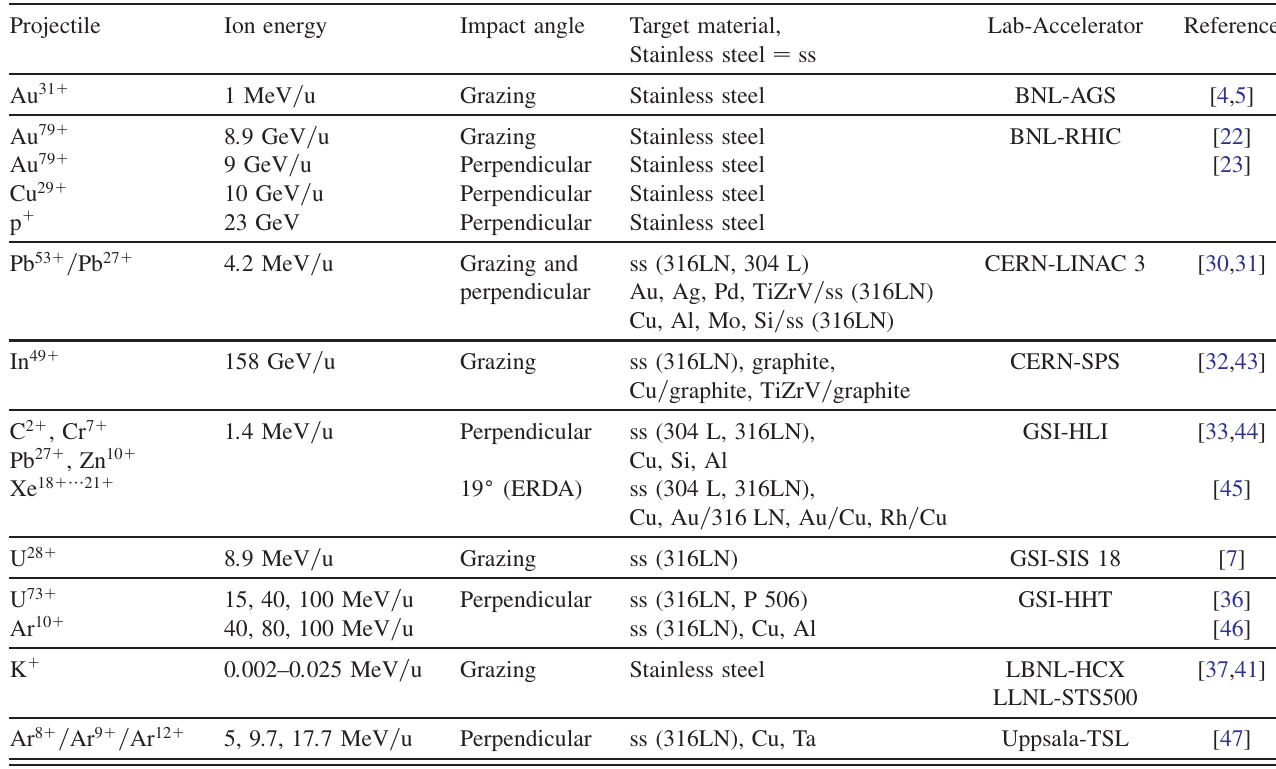
TABLE I. Overview of heavy-ion-induced desorption experiments at particle accelerators worldwide. The different types of ions, charge states, energies, impact angles, and target materials are compared between the different laboratories. Desorption experiments were performed between 1998 and